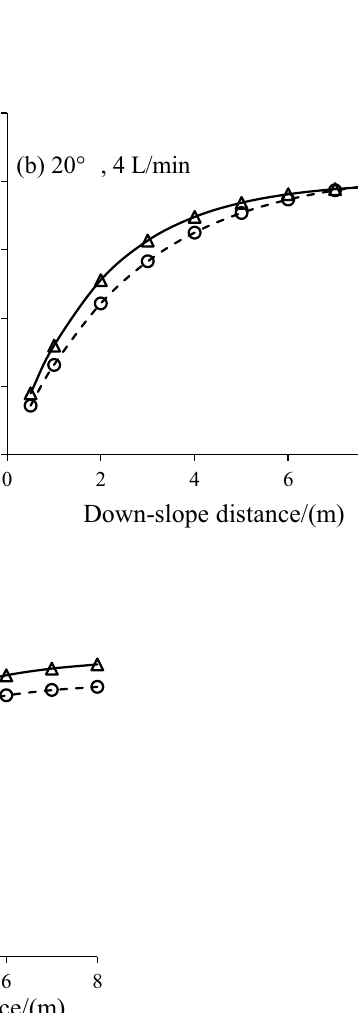
Table 2. Regression parameters between experimental data and mathematical model.